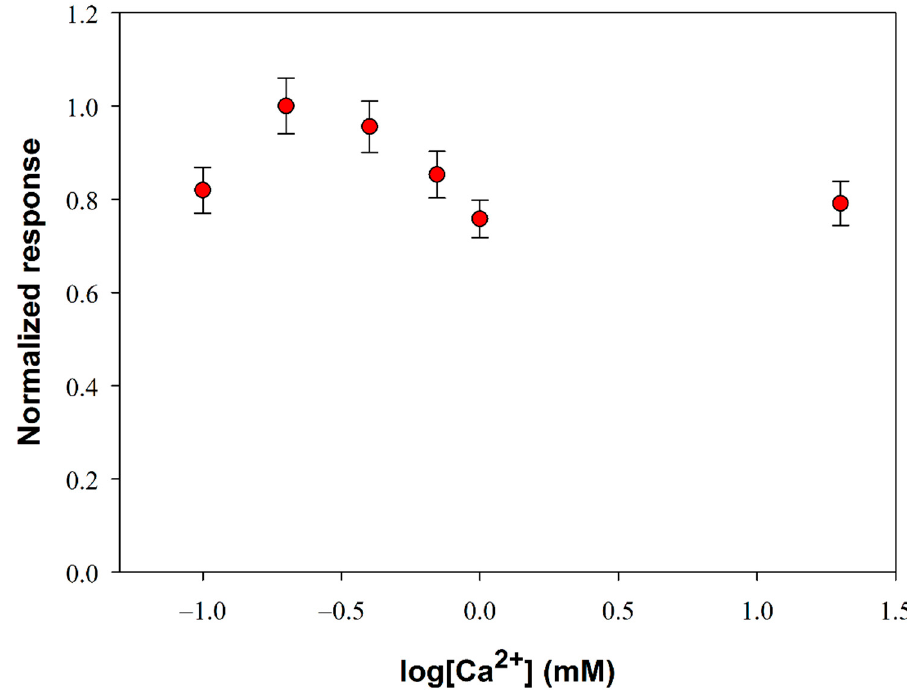
Figure 2. Normalized response (i.e., response/maximum response) of a typical Pt/PPyox/ChO biosensor to PLD 0.22 IU/mL as a function of Ca 2+ concentration. Supporting electrolyte: Tris buffer pH 8.0, I 0.05 M containing 0.75% (v/v) Triton X-100 and 5 mM phosphatidylcholine. Electrode rotation rate: 1000 rpm. Each value represents the mean of triplicate measurements; the error bars represent the relevant standard deviations.